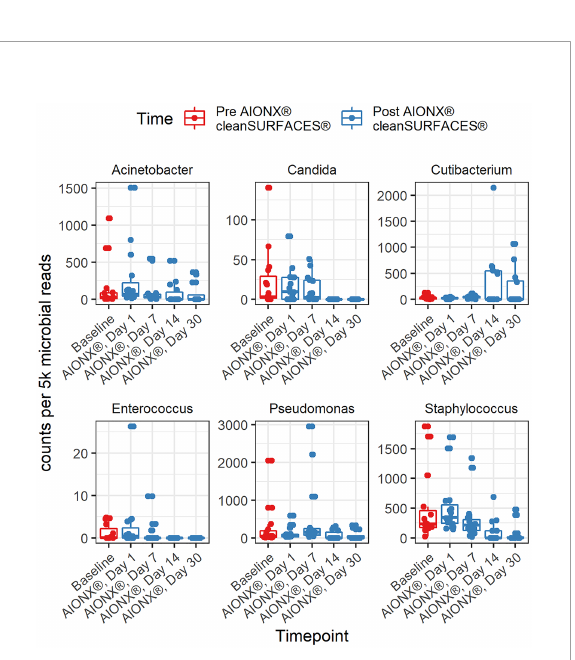
FIGURE 3 Normalized counts of genera associated with Hospital Acquired Infections, during cleanSURFACES ®